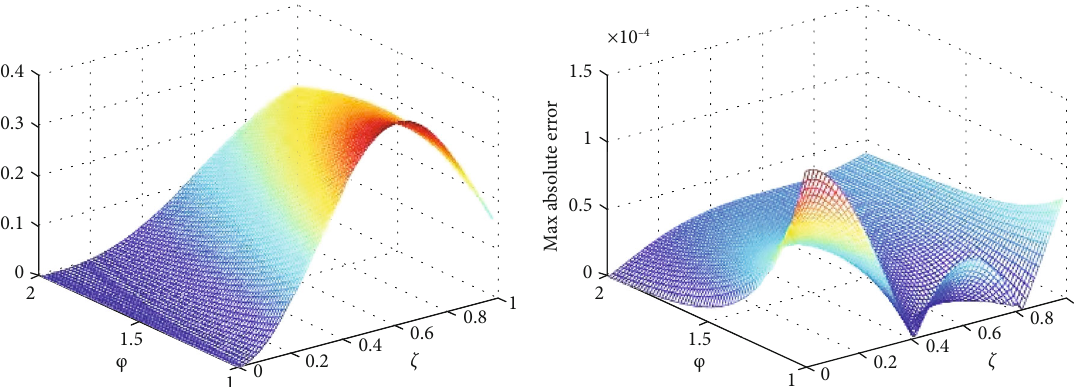
Figure 1: Exact and approximate φ -RL integration of the function f ð ζ Þ = sin ð 5 ζ Þ for J = 6 and various choices of ρ and their maximum absolute error.